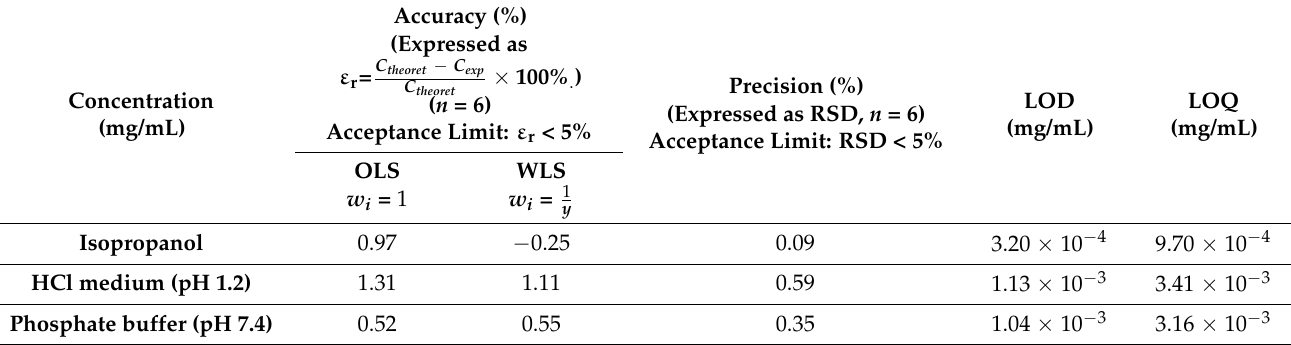
Table 4. Accuracy and precision of the UV